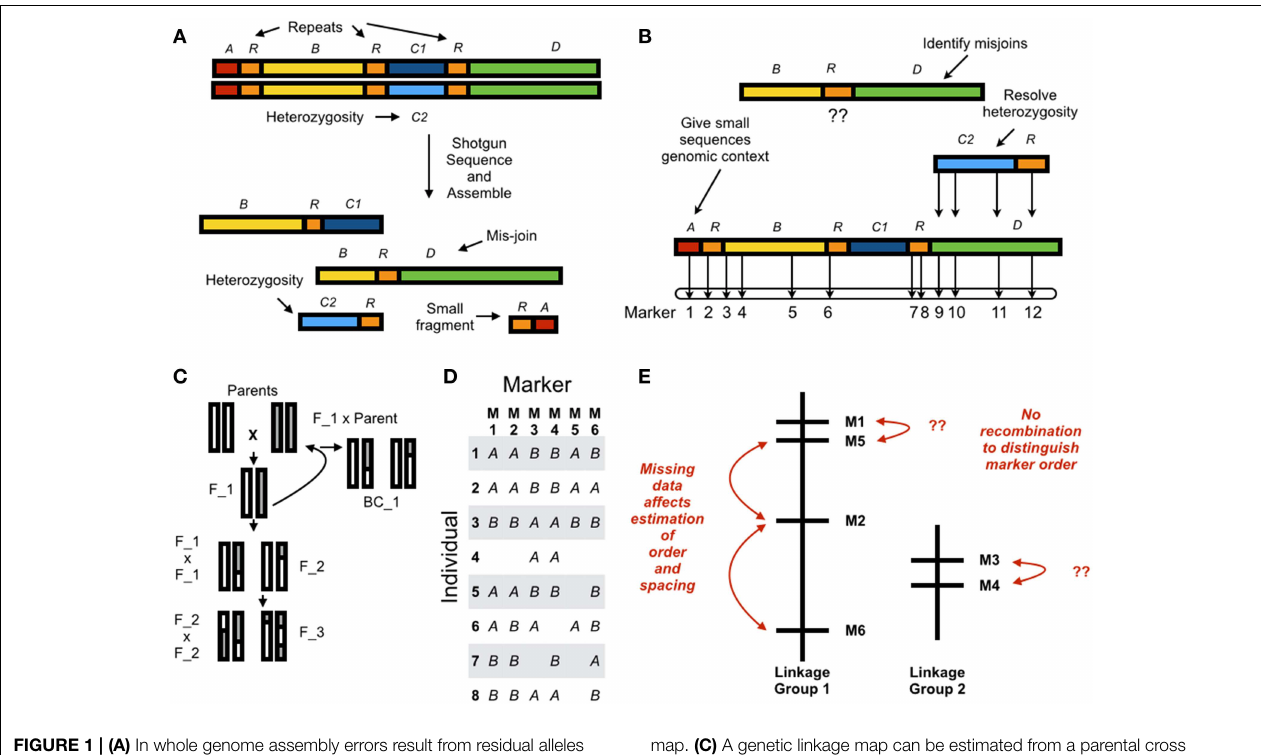
map. (C) A genetic linkage map can be estimated from a parental cross resulting in an F2, F3, or Backcross (here, BC1) population. Estimating a genetic linkage map requires (D) genotyping individuals at discrete markers (here, six markers across eight individuals with missing data); and (E) grouping markers into linkage groups; and ordering and spacing markers within linkage groups. Estimating order and spacing is difficult due to missing data and little recombination between adjacent